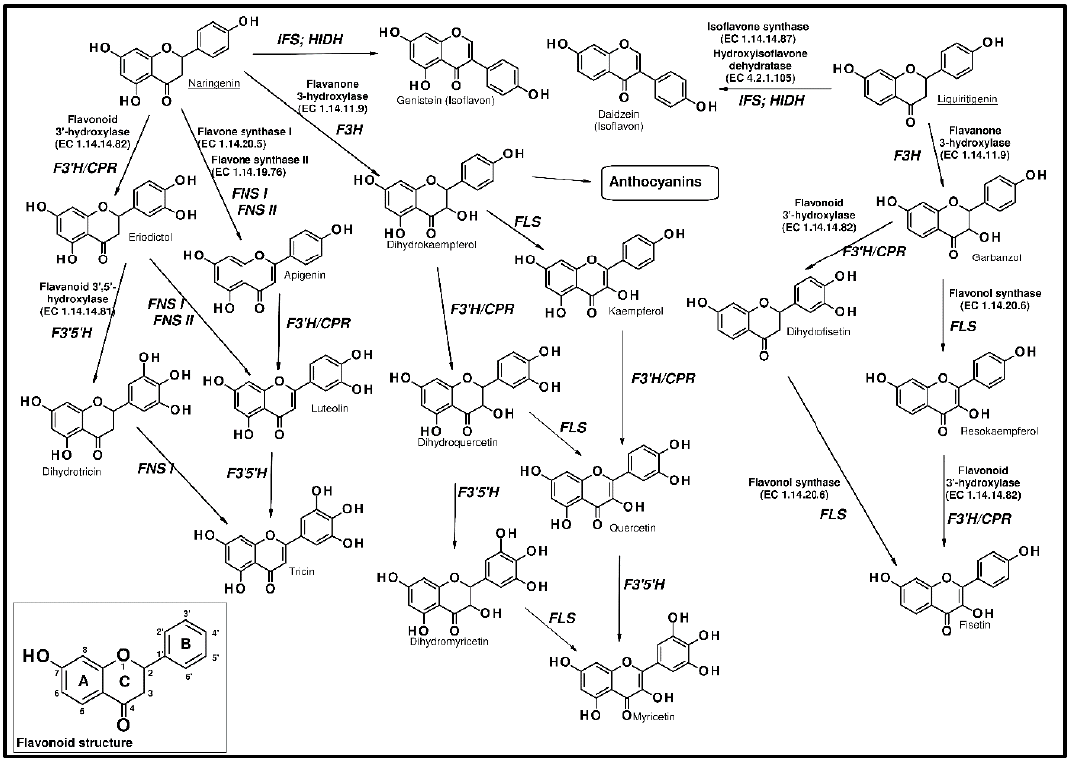
Figure 4. The flavonoid structure and biosynthetic pathways of major flavonoid compounds.